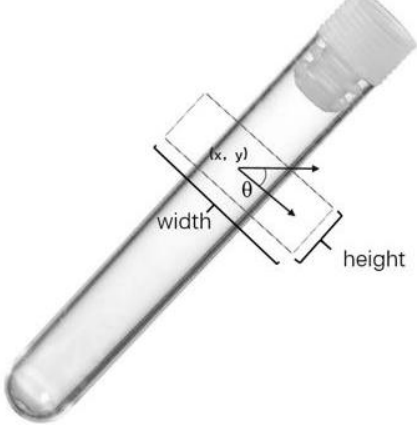
Figure 15. Grasping pose.